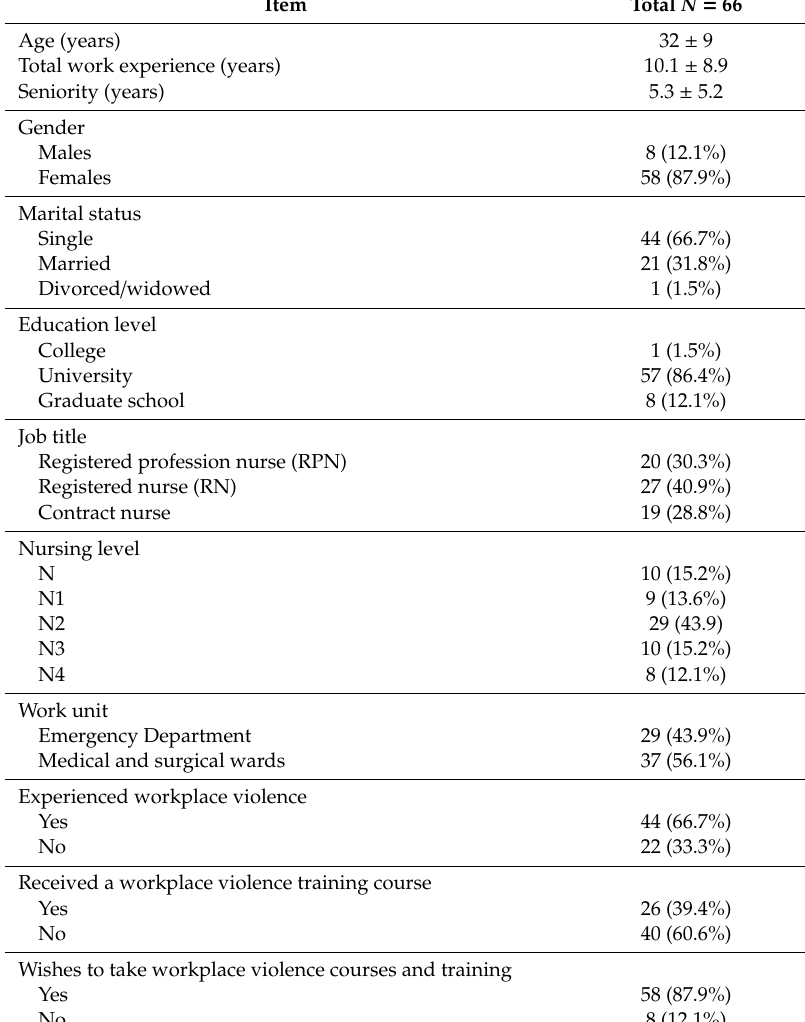
Table 2. Participants’ sociodemographic